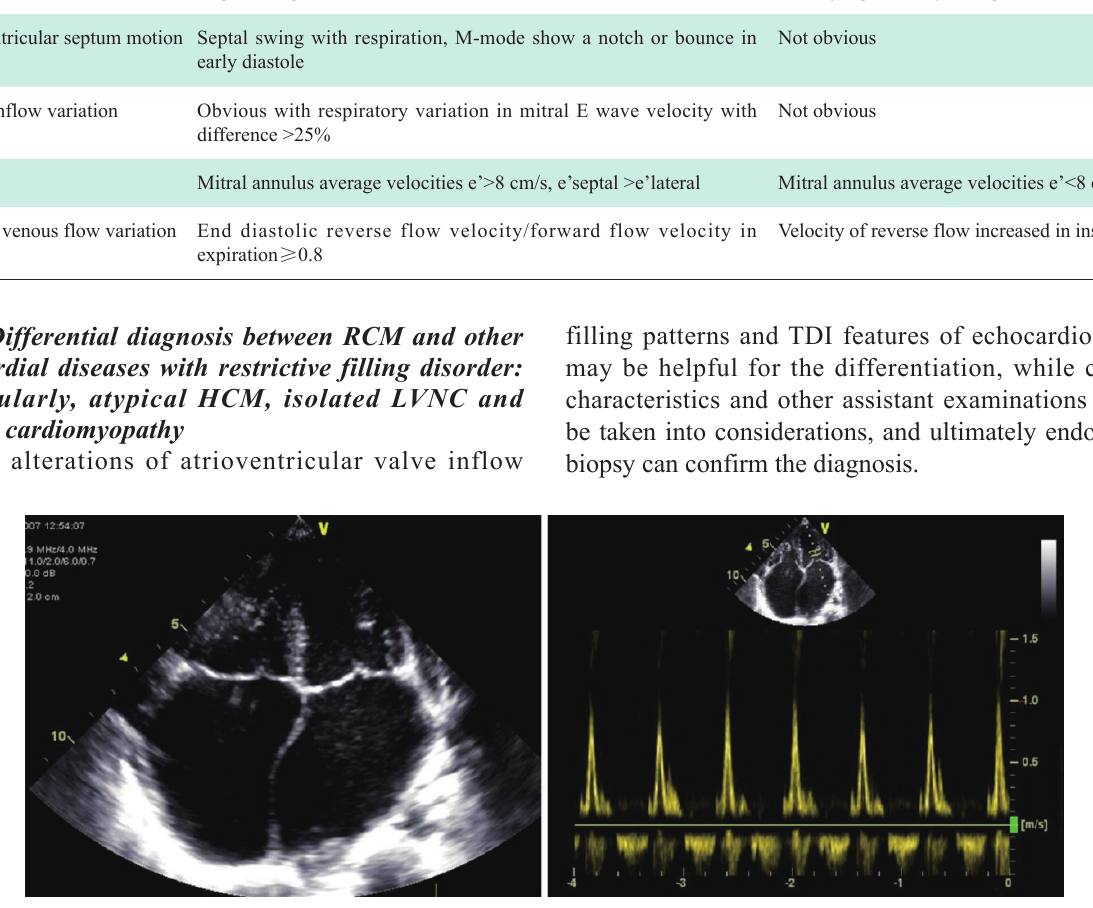
Figure 6 Restricted cardiomyopathy shows bi-atrial enlargement, reduced left ventricular size, and abnormal restrictive filling pattern of mitral flow spectrum during diastole with E/A >